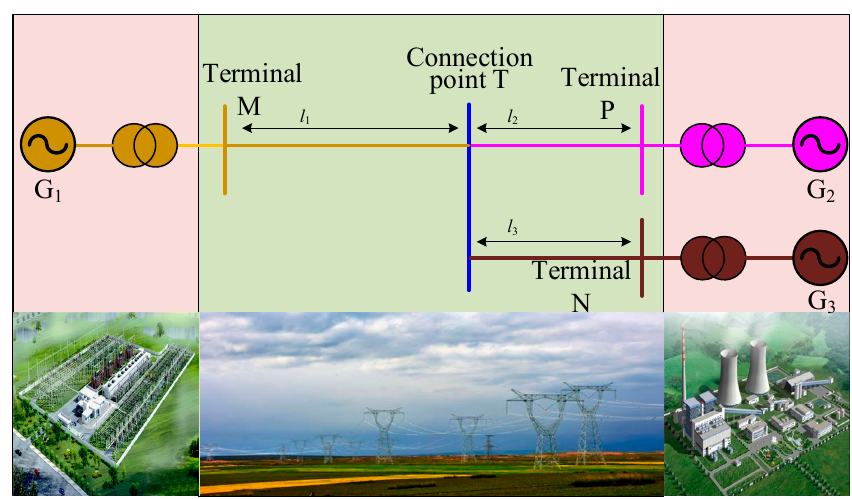
Figure 1. T-connection transmission line topology structure diagram.